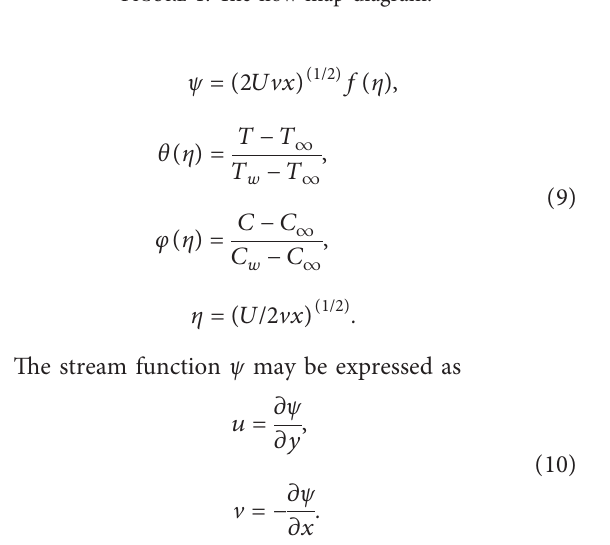
Figure 1: The flow map